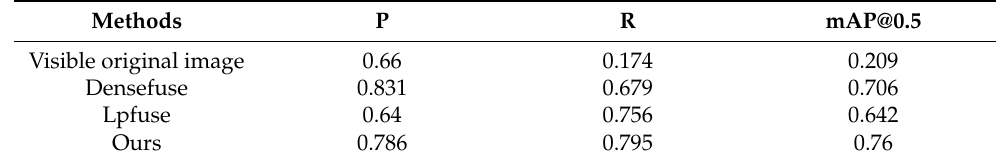
Table 3. The detection effect comparison of multi-sample data augmented images and original images at night. Methods P R mAP@0.5 Visible original image 0.66